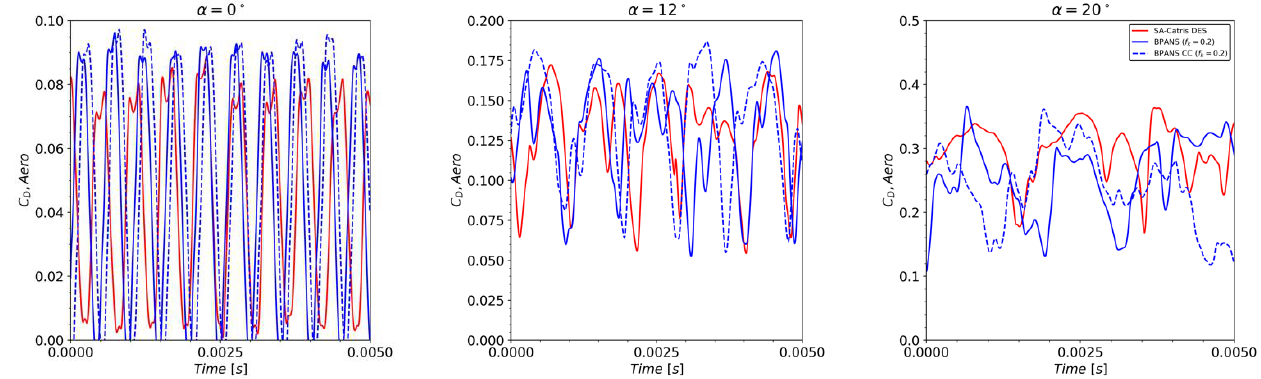
Figure 7. Surface pressure coefficient statistics with variance for the SRP configuration.